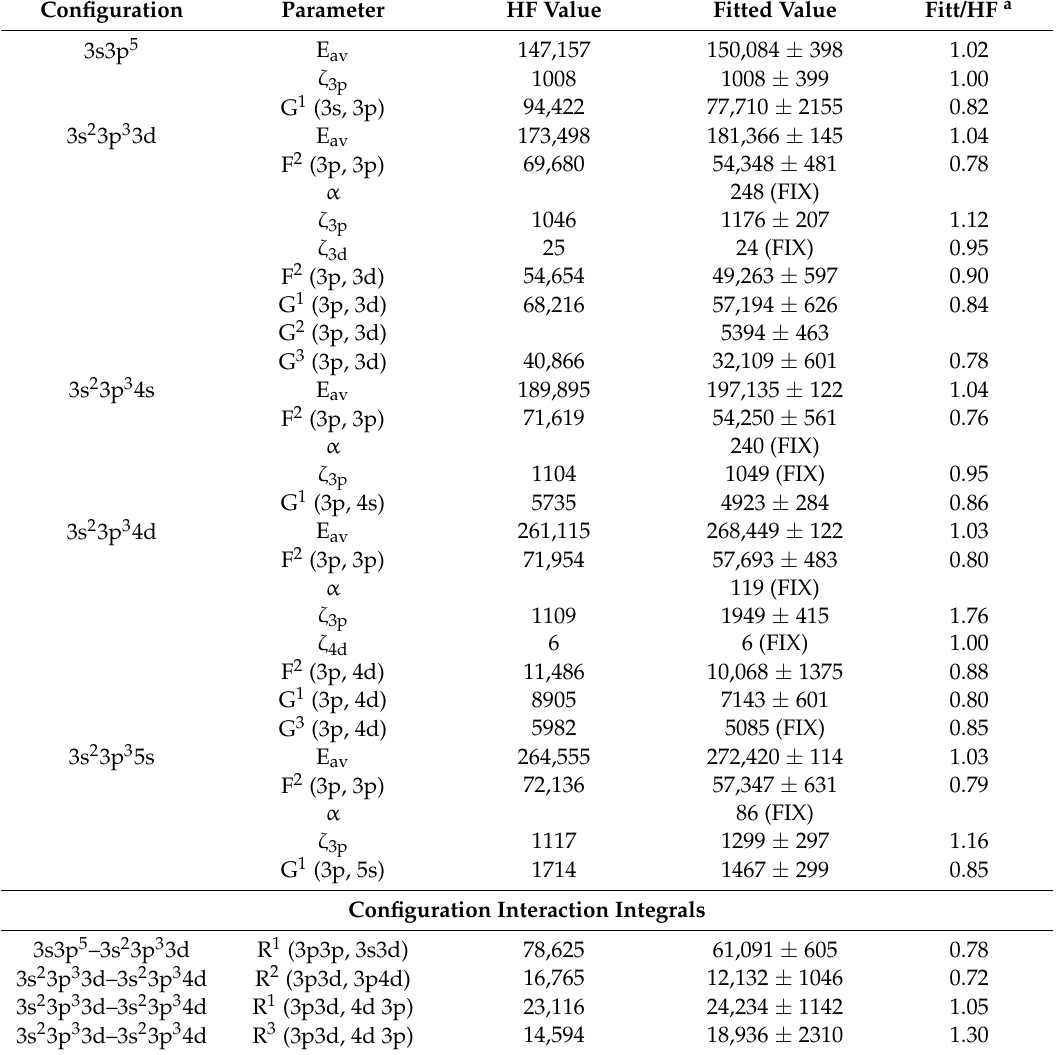
a Parameters omitted from this table: direct and exchange integrals, and spin-orbit ζ parameters set to 85% and 95% of their HFR values, respectively; CI integrals were set to 85% of their HFR values. The standard deviation for the energy adjustment was 339 cm − 1